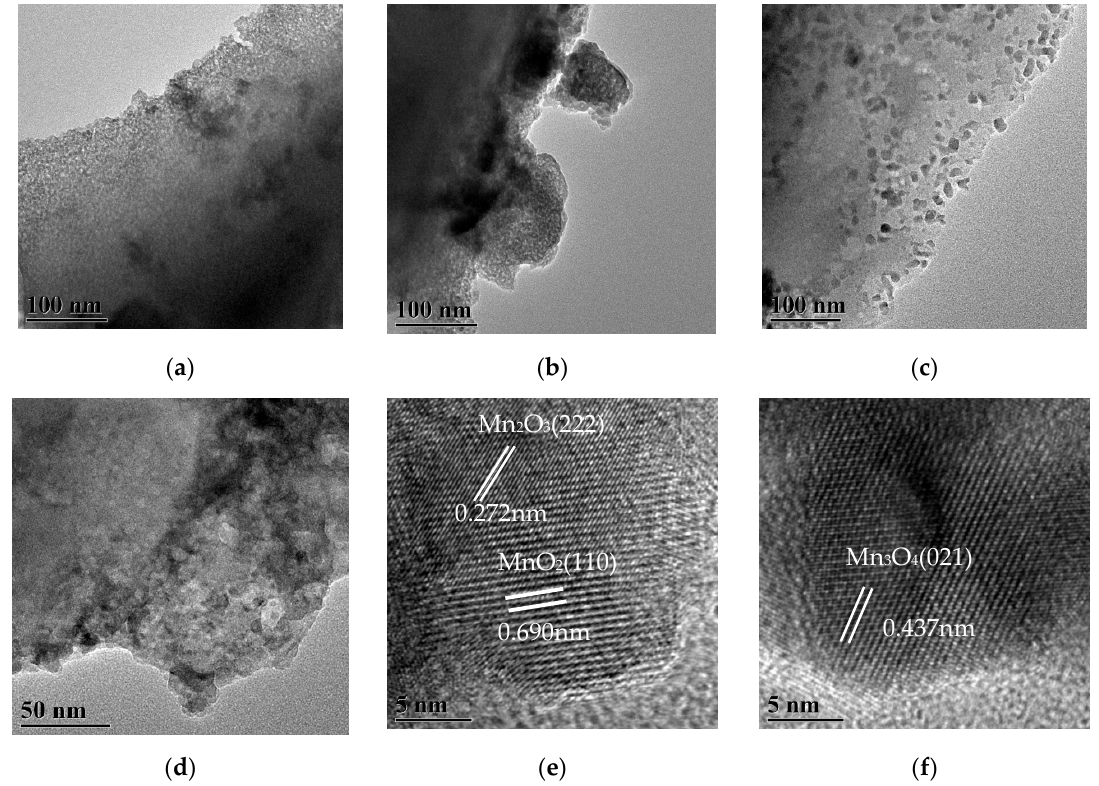
/ HZ-ET, ( e – f ) HR-TEM images of the MnO